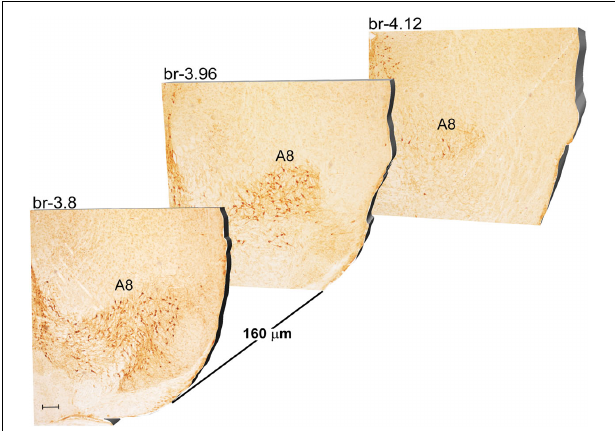
FIGURE 3 | Rostro-caudal reconstruction of the A8 catecholaminergic nucleus. TH immunostaining in 20 µ m coronal mouse brain sections regularly collected every 160 µ m from –3.8 to –4.12 Bregma levels. The figure shows a 3D-like antero-posterior reconstruction of the A8 catecholaminergic nucleus. Scale bar: 200 µ m.